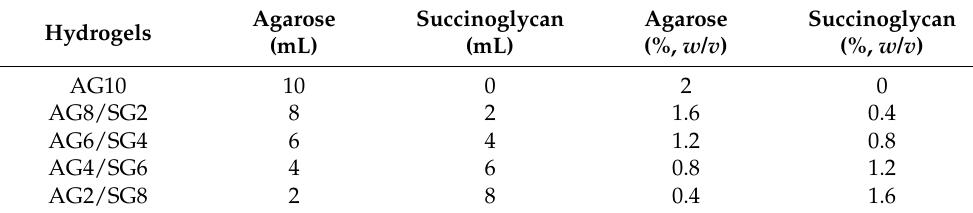
Table 1. Hydrogel compositions of various agarose and succinoglycan proportions. Agarose Hydrogels